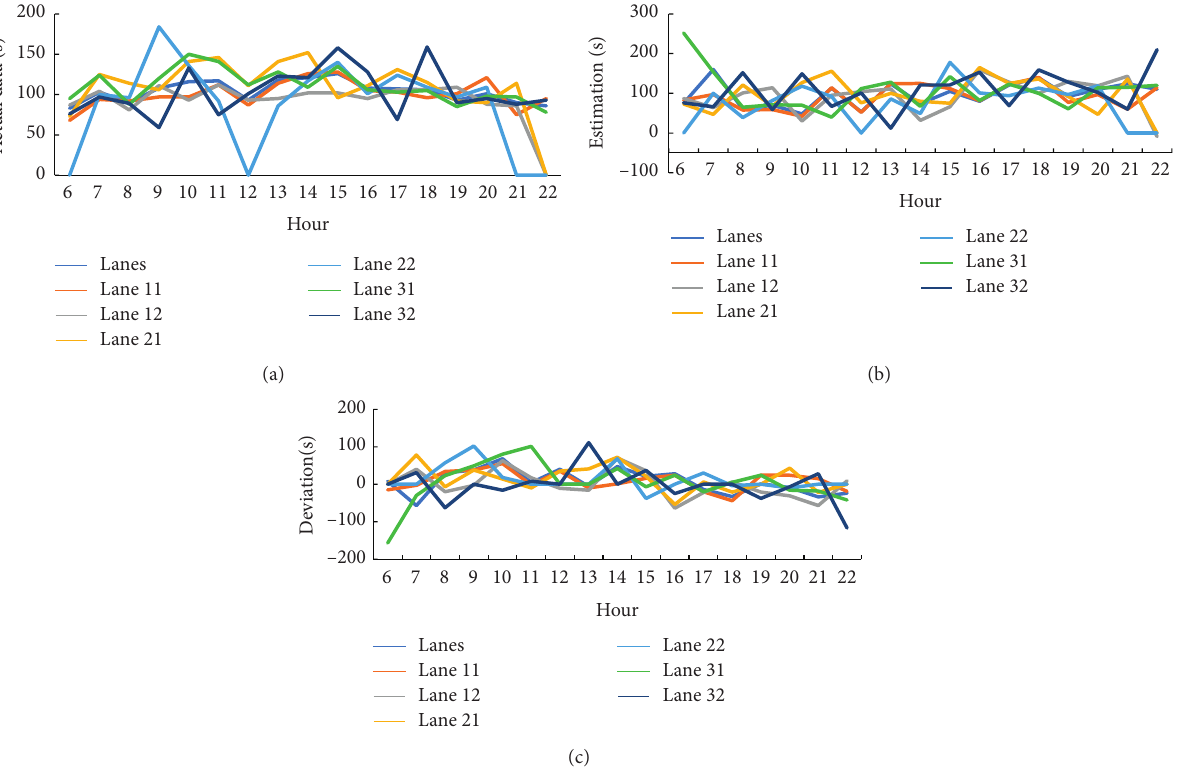
Figure 10: Actual value vs. estimated value vs. deviation: (a) actual value, (b) estimated value, and (c) deviation.